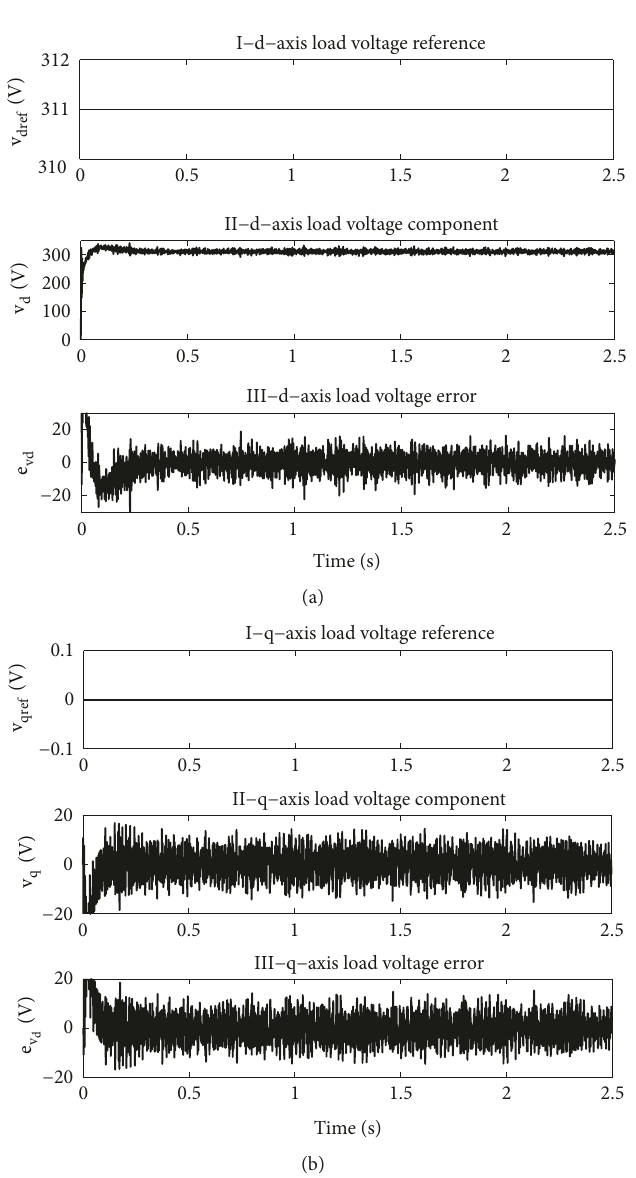
Figure 7: Performances of the inverter side PI controllers in stand-alone mode. (a) d-axis load voltage reference (i), d-axis load voltage component (ii), and d-axis load voltage error (iii). (b) q-axis load voltage reference (i), q-axis load component (ii), and q-axis load voltage error